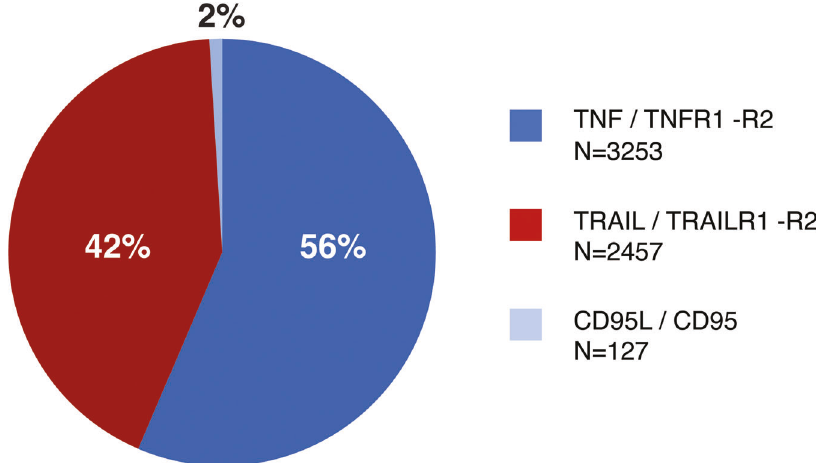
Fig. 4 Contribution of the CD95L/CD95 system in therapeutic-end studies. Graphic representation of the distribution of the number of patents targeting the most studied cell Death Receptors CD95, TNFR1 and -R2, TRAILR1 and -R2 and their respective ligands CD95L, TNF alpha, and